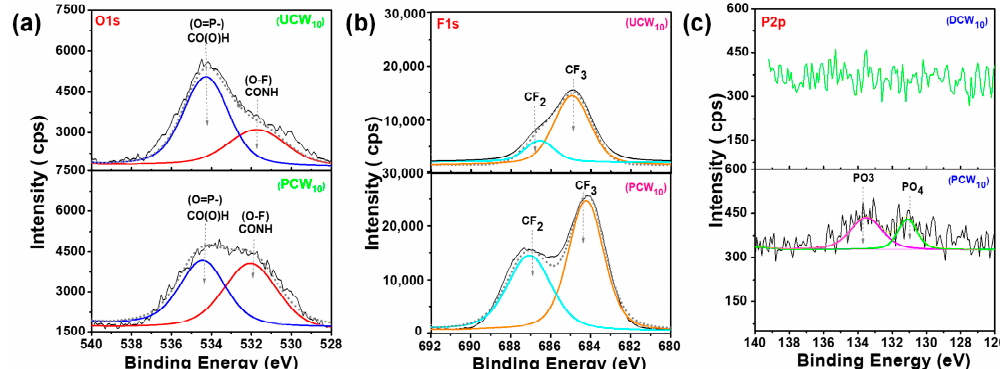
Table 2. Surface elements of aramid samples by XPS .